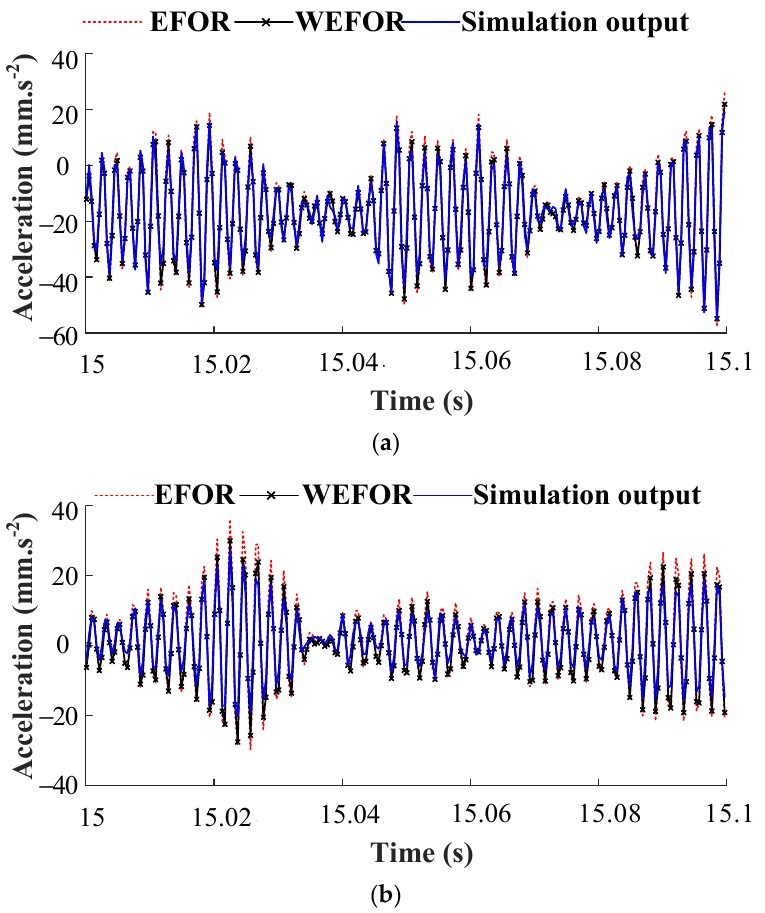
Figure 11. Comparison among the WEFOR output, the EFOR output, and the simulation output. ( a )